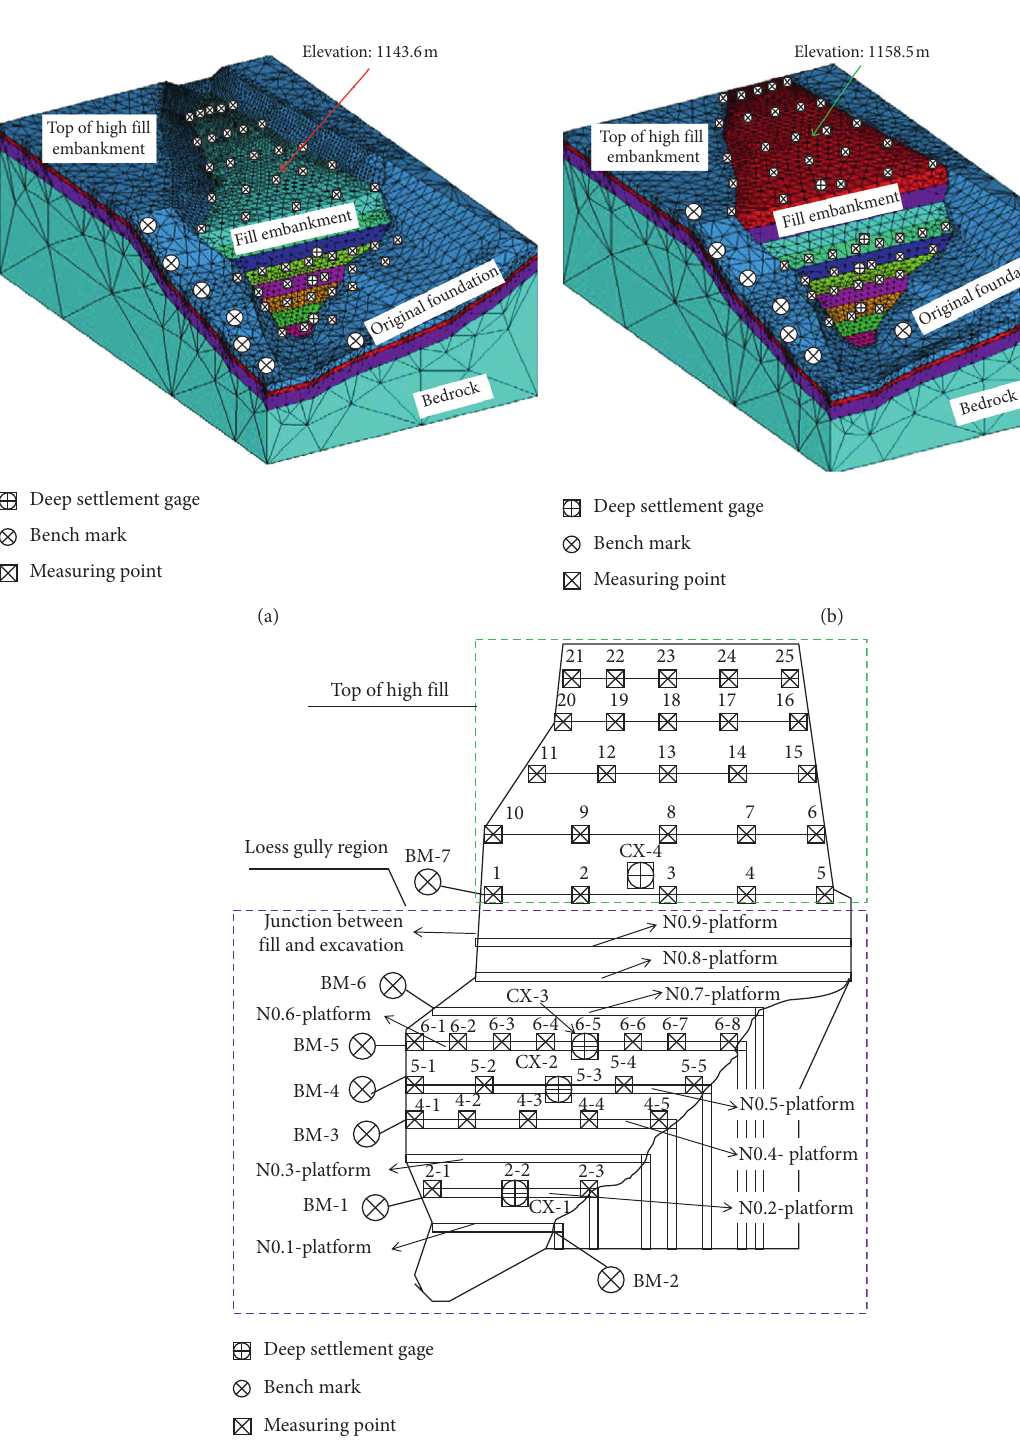
Figure 10: In situ monitoring points’ layout of the test section of Lvliang Airport. (a) Monitoring points during the intermission period (Elevation: 1143.6m). (b) Monitoring points during the completion period (Elevation: 1158.5m). (c) Measuring points layout from the top view of the 3D